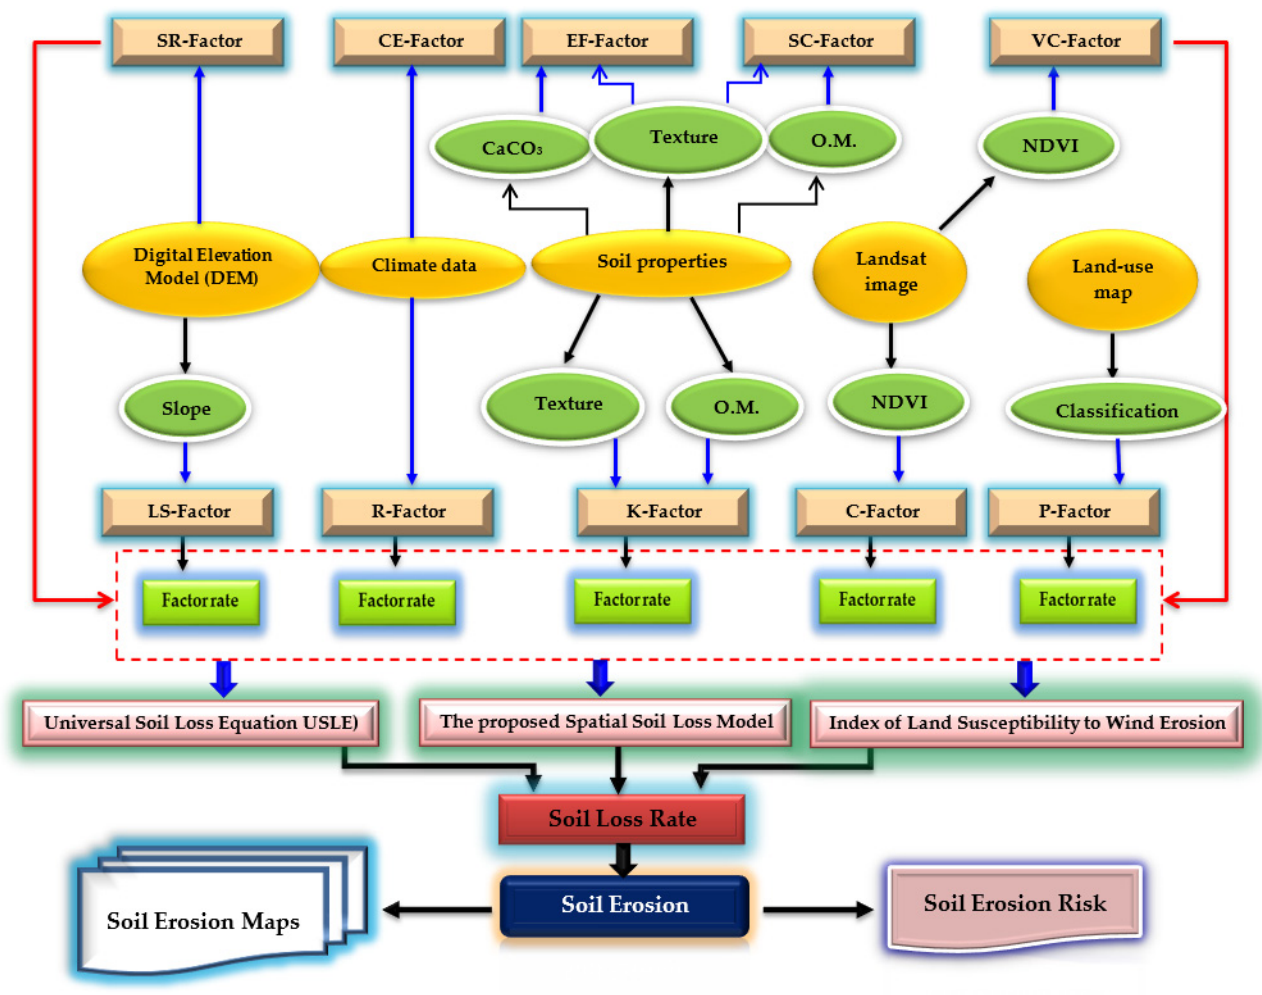
Figure 3. A flowchart of soil erosion quantification.